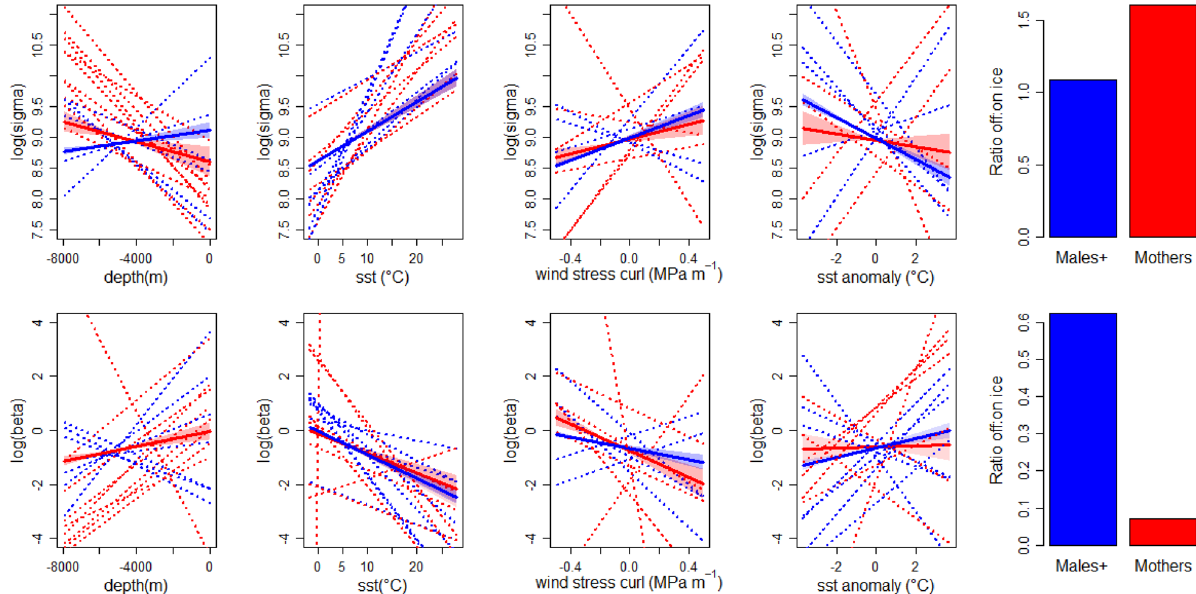
Figure 3. Thick lines indicate the predicted effect of environmental covariates on sigma ( σ , top row) and beta ( β , bottom row) in the log scale for mothers (red) and males + (blue), based on the best population model (P-model). Shaded areas indicate 95% confidence intervals. Thin dotted lines indicate individual model (I-models) predictions for each tagged whale. Bar plots indicate the effect of ice on σ and β as the ratio between the intercepts for the linear predictors and the intercepts plus the effect of the binary variable